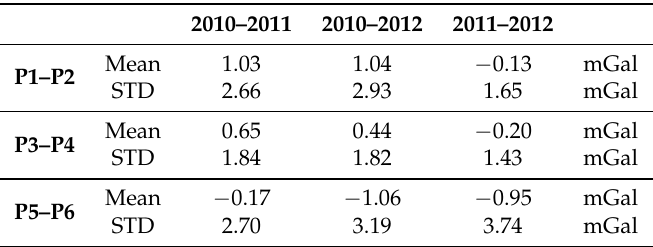
Table 2. Mean and standard deviation (STD) of the difference in gravity estimates (100 s full wavelength filtering) along the three Operation IceBridge (OIB)